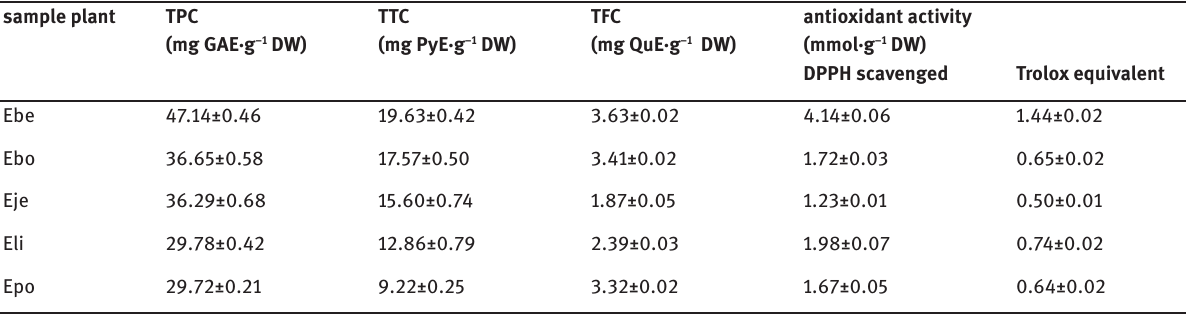
Table 2: Polyphenolic content of E. brasiliensis in plant materials from different locations . sample plant